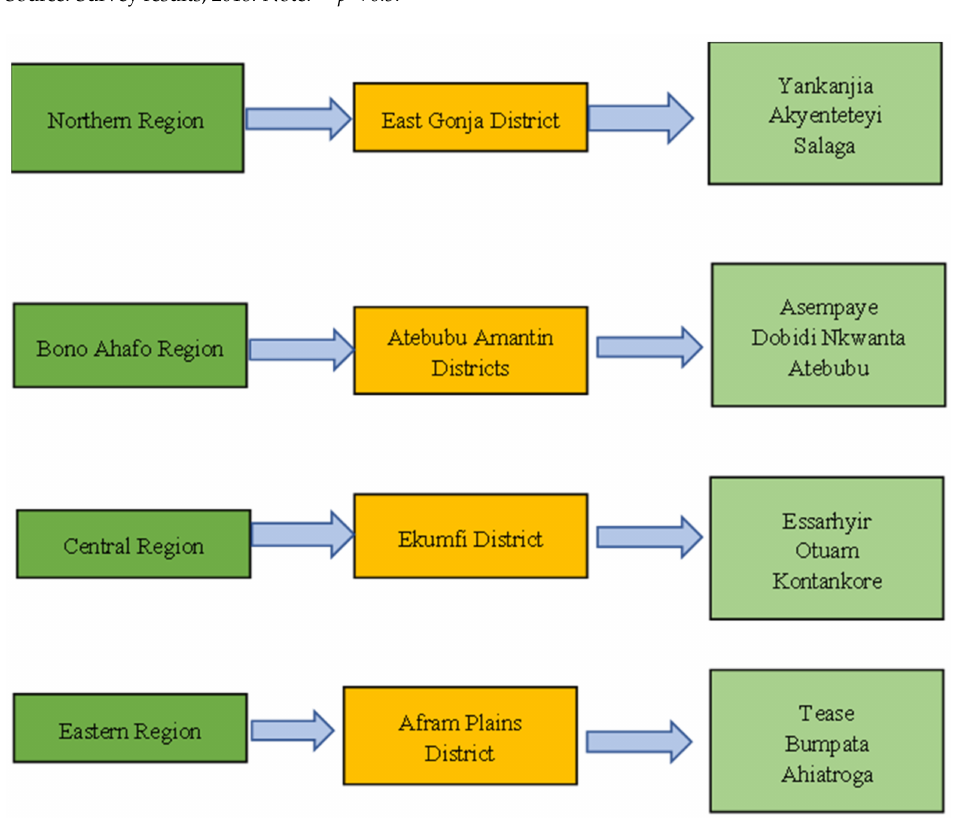
Figure A1. Diagram of household sample selection